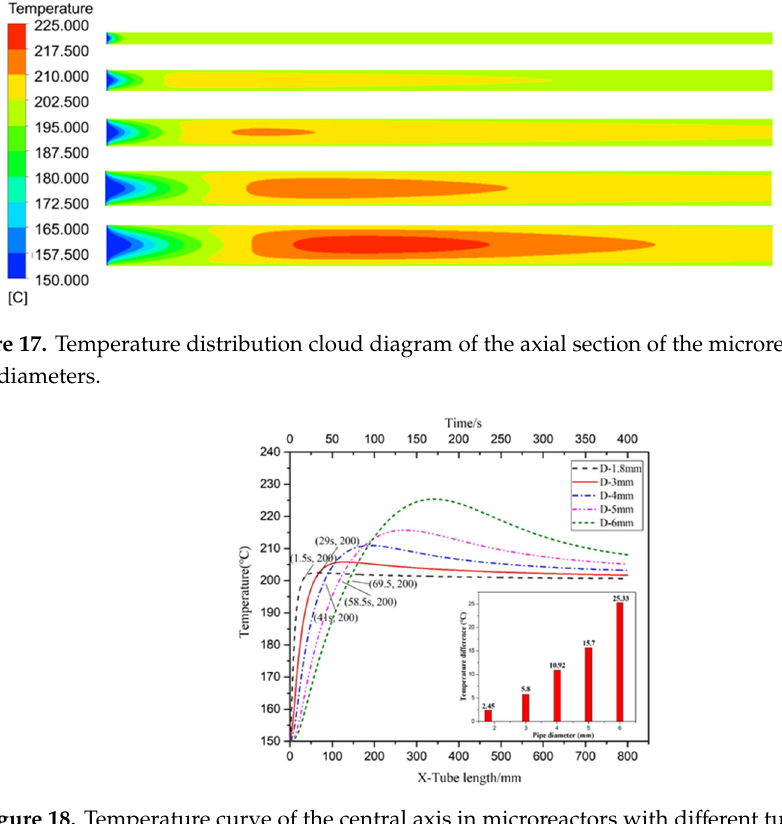
Figure 18. Temperature curve of the central axis in microreactors with different tube diameters.